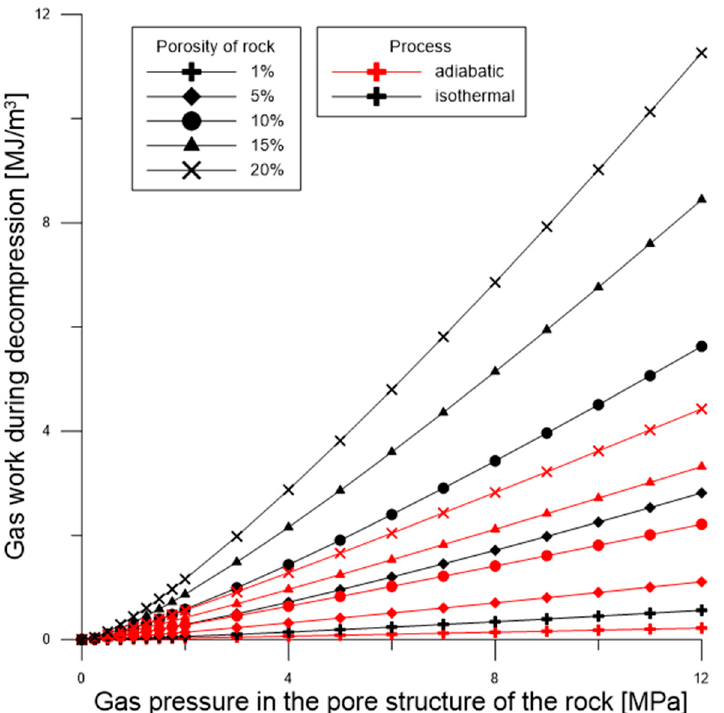
Figure 1. Work released during the decompression of gas from the porous structure of rock as a function of pressure.